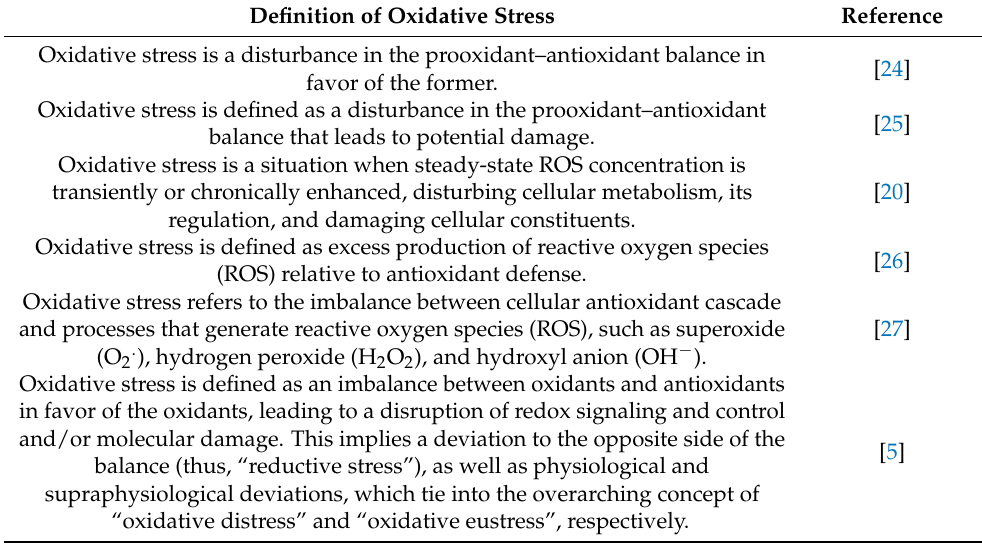
Figure 1. Classifications of oxidative stress adapted with permission from Sies et al. [4]. Copyright 2017 Annual Reviews, Inc. Table 1. Some proposed definitions of oxidative stress throughout the course of